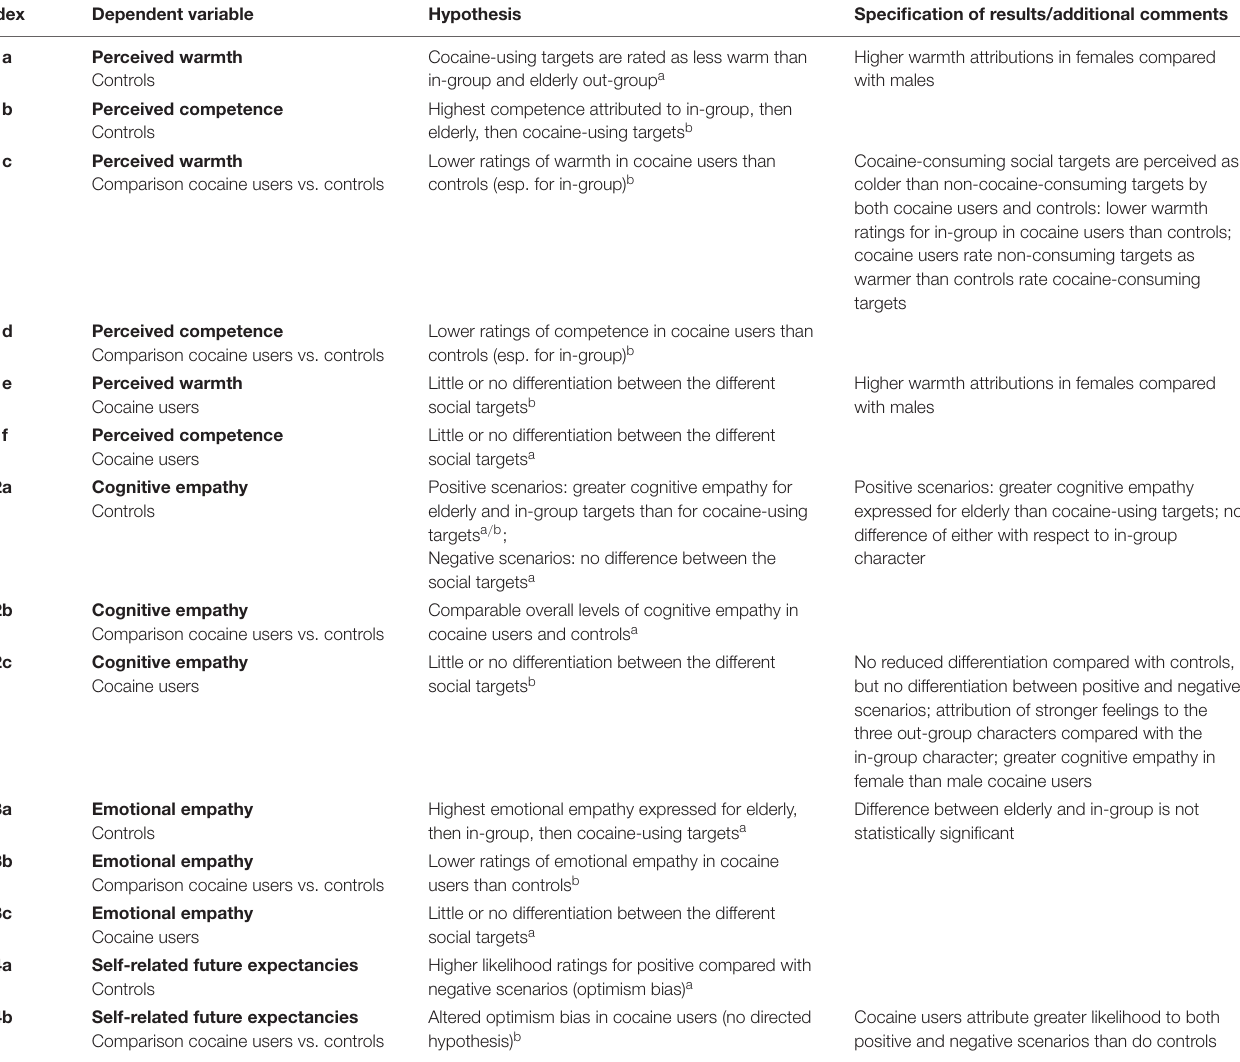
TABLE 1 | List of